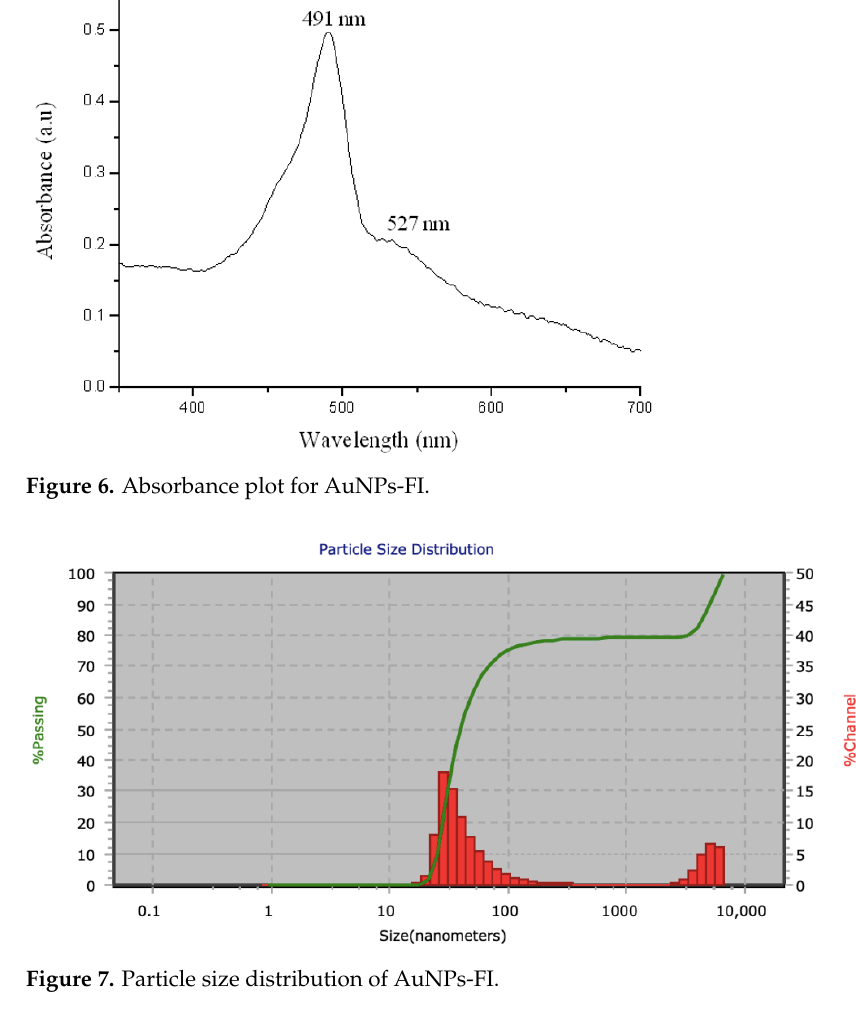
Figure 8. ( a ) SEM photo and ( b ) TEM image of AuNP-Fl.